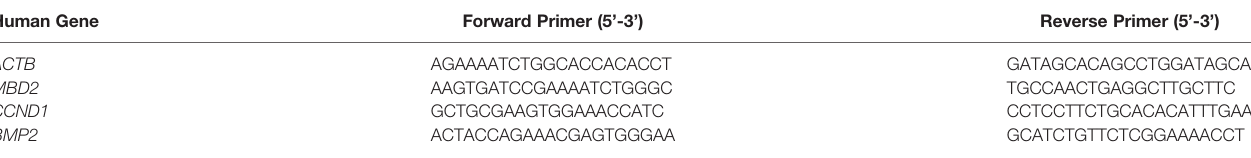
TABLE 2 | List of primers used for RT-qPCR in HPASMCs. Human